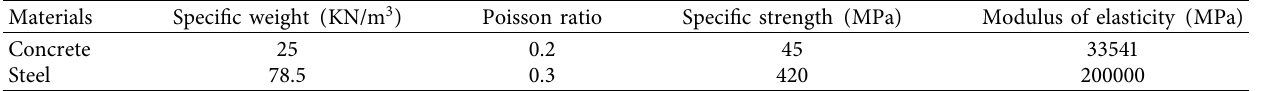
Table 3: Material properties.